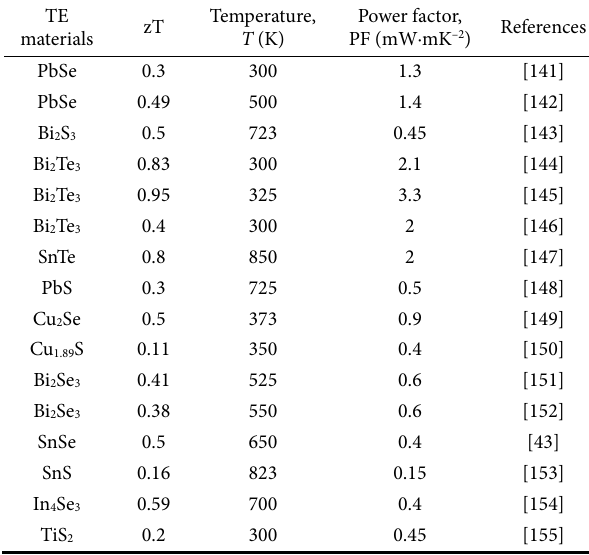
Figure 9 Temperature dependence (a) electrical resistivity, (b) Seebeck coefficients, (c) thermoelectric power factor, (d) thermal conductivity and (e) zT of Cu 12 Sb 4 S 13– x Se x thermoelectric solid solution for ( x = 0, 0.5, 1 and 2). Adapted with permission from Refs. [129], © The Royal Society of Chemistry 2016. Table 3 Undoped MCs thermoelectric materials with their respective figure of merit